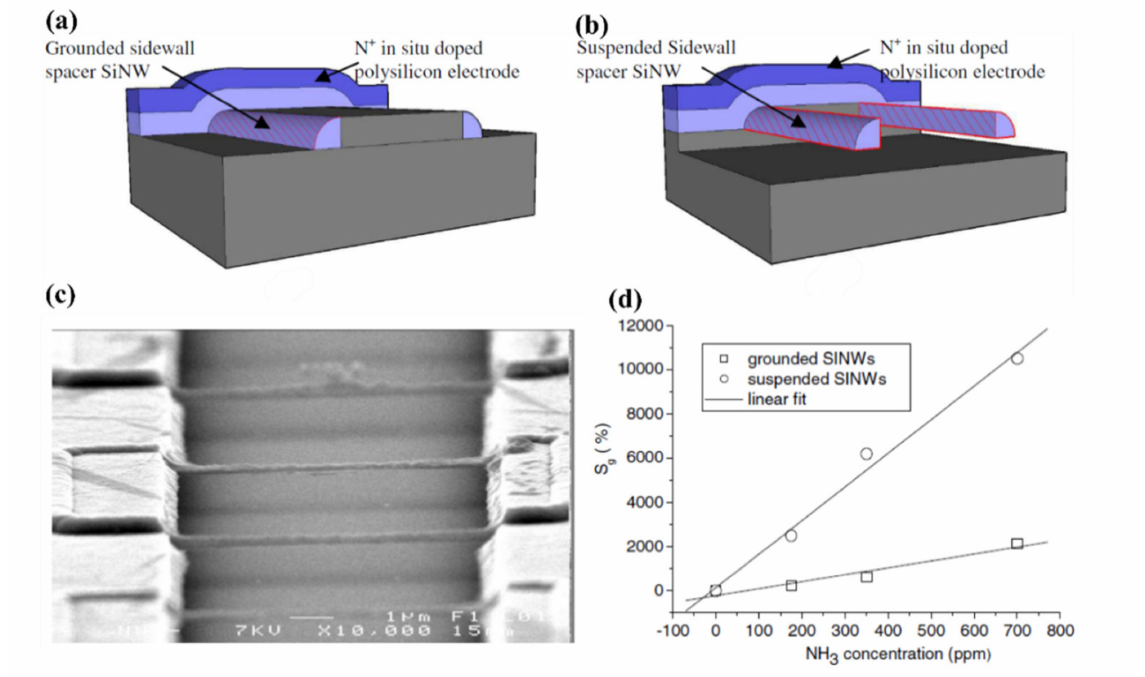
Figure 9. Schematic view of grounded ( a ) and suspended ( b ) sidewall spacer polycrystalline SiNWs. ( c ) SEM image of suspended polycrystalline SiNWs based sensing structure. ( d ) Relative response (S g = (R g − R) / R g ) of the sensors vs. the ammonia concentration for both suspended and grounded SiNWs resistors. Reproduced from [135].